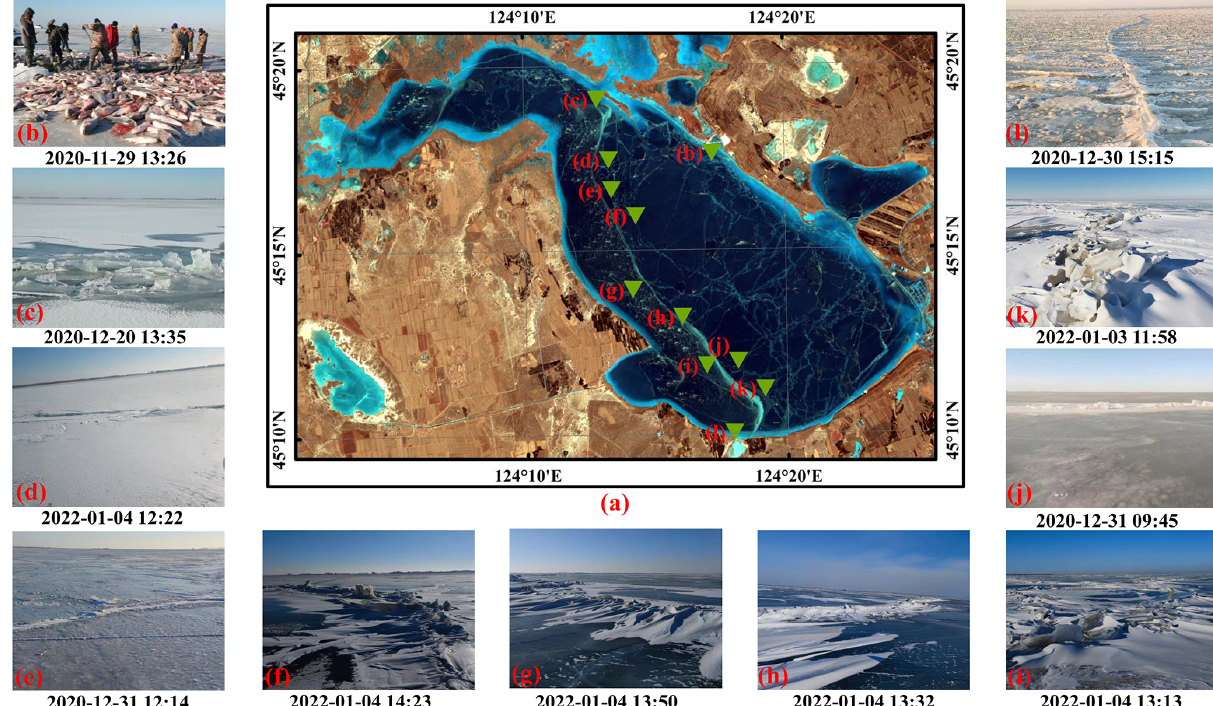
Figure 1. The spatial distribution of Chagan Lake and field photographs. Panel (a) is provided by the Landsat 8 Operational Land Imager (OLI) on 10 February 2019, with the band composite of R(5) + G(4) + B(3). Panels (b) – (h) display the field photographs captured in field investigations.